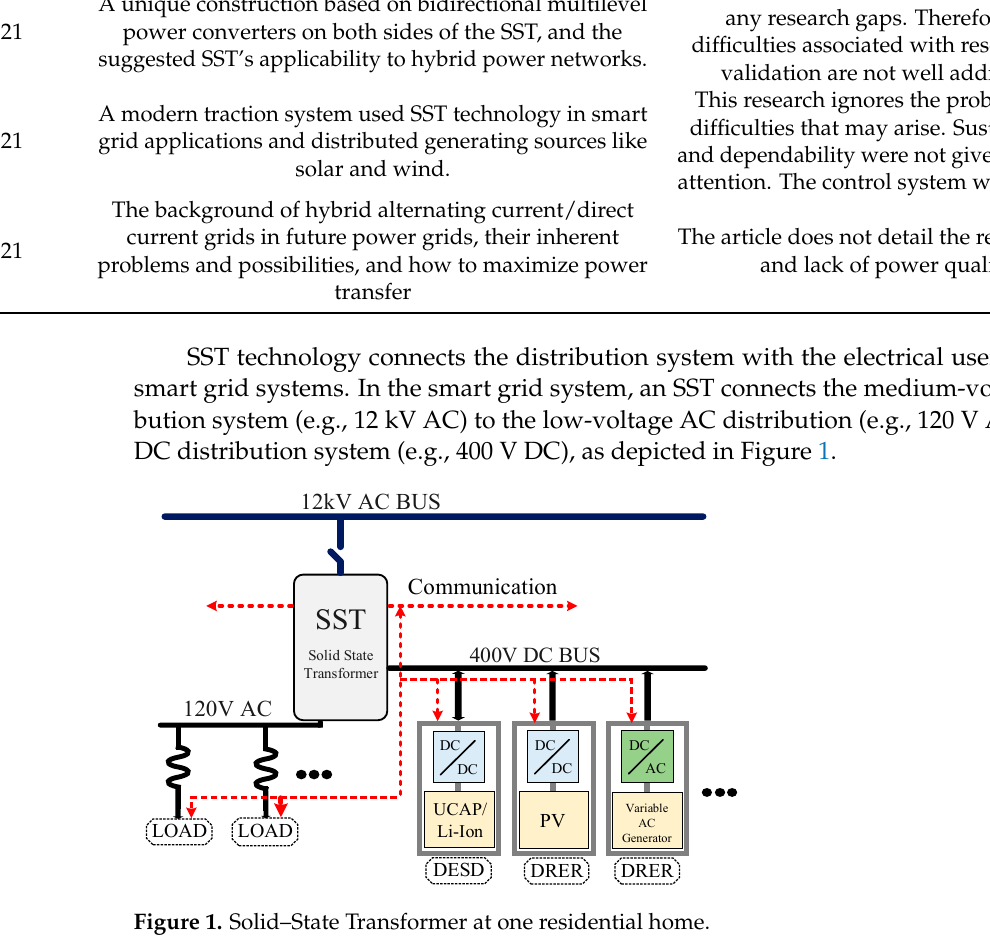
Table 1. Research topics and key factors of SST technology.